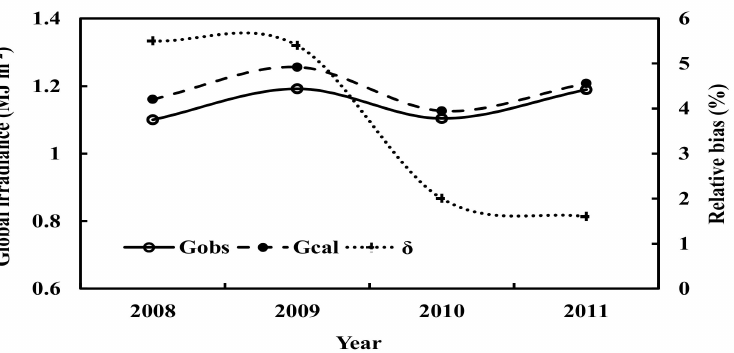
Figure 4. The observed and calculated annual averages of hourly global solar irradiance (G obs and G cal ) and relative biases ( δ ) in all sky conditions at Sodankylä. According to above evaluations, the estimated hourly, monthly and annual mean global irradiance corresponded with the observed